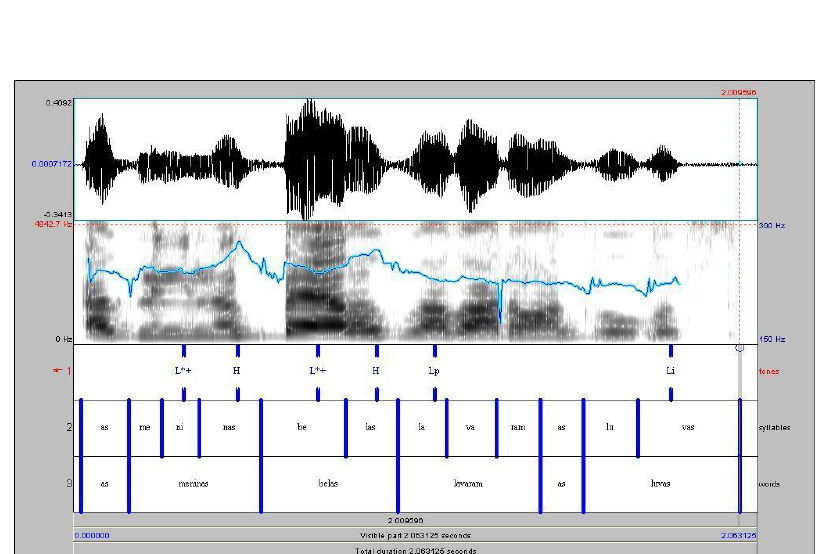
Figure 5. F 0 contour of the subject-focus sentence As meninas belas lavaram as luvas ‘The beautiful girls washed the gloves’ produced by T in the context of narrow-focus on the